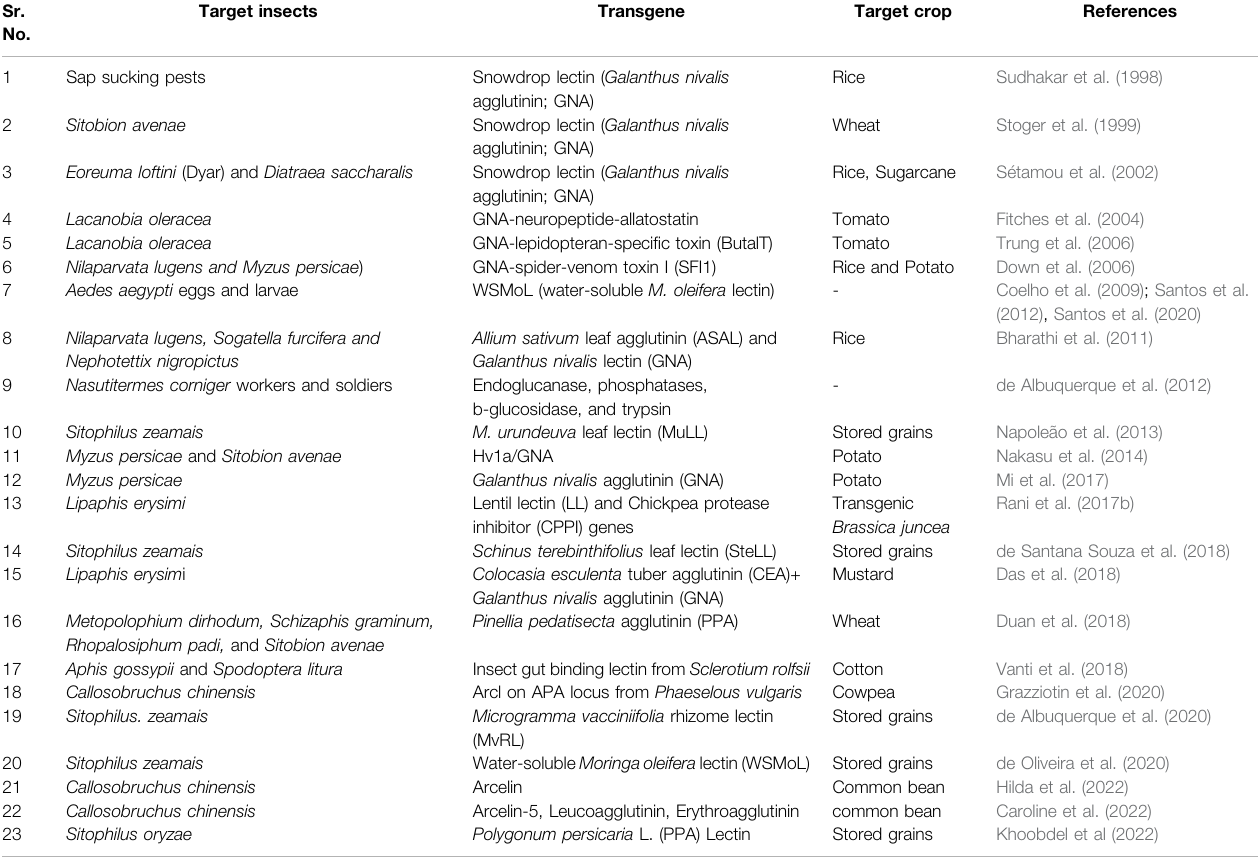
TABLE 3 | Expression of lectin genes for insect resistance. Sr. No.